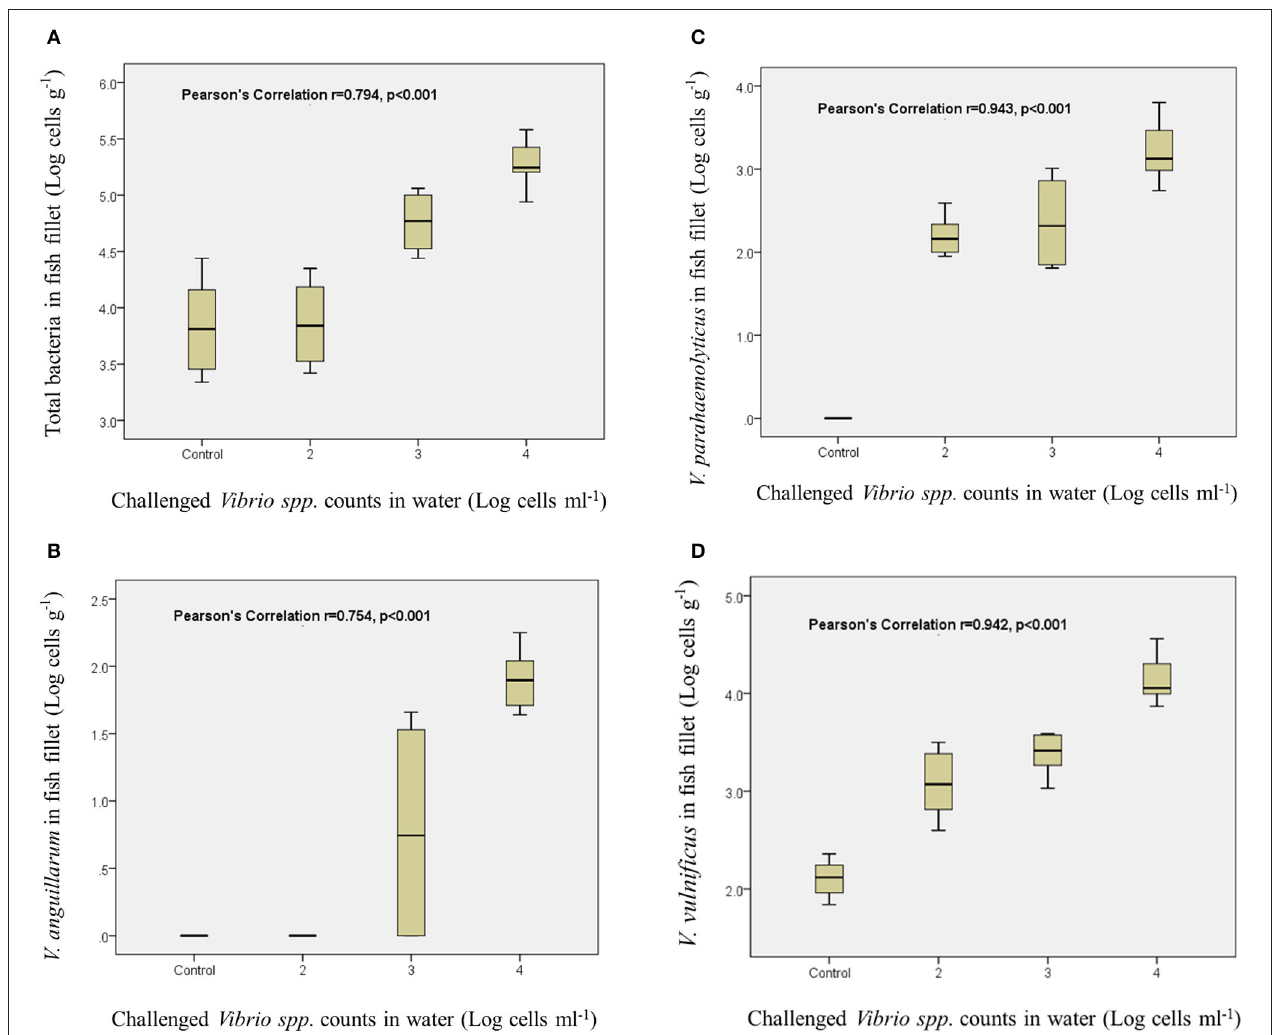
FIGURE 6 | Each figure represents the correlation between challenged Vibrio spp. counts in water and total bacteria counts in fish fillet (A), V. anguillarum counts in fish fillet (B) , V. parahaemolyticus counts in fish fillet (C) , and V. vulnificus counts in fish fillet (D) .